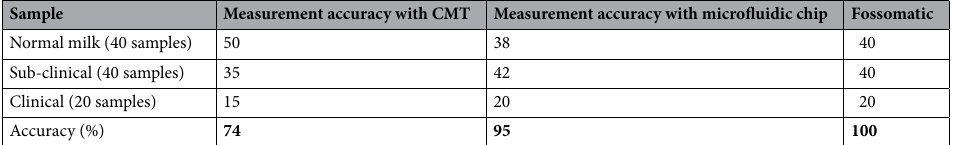
Table 2. Number of errors under measurement of SCC in milk using the CMT method and microfluidic chip compared to the measurement